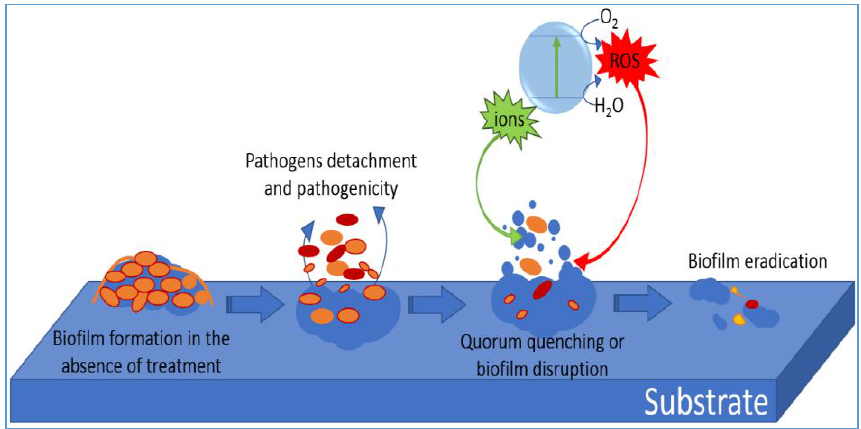
Figure 12. Strategies to neutralize the damage of toxic films spreading pathogens into the environment.